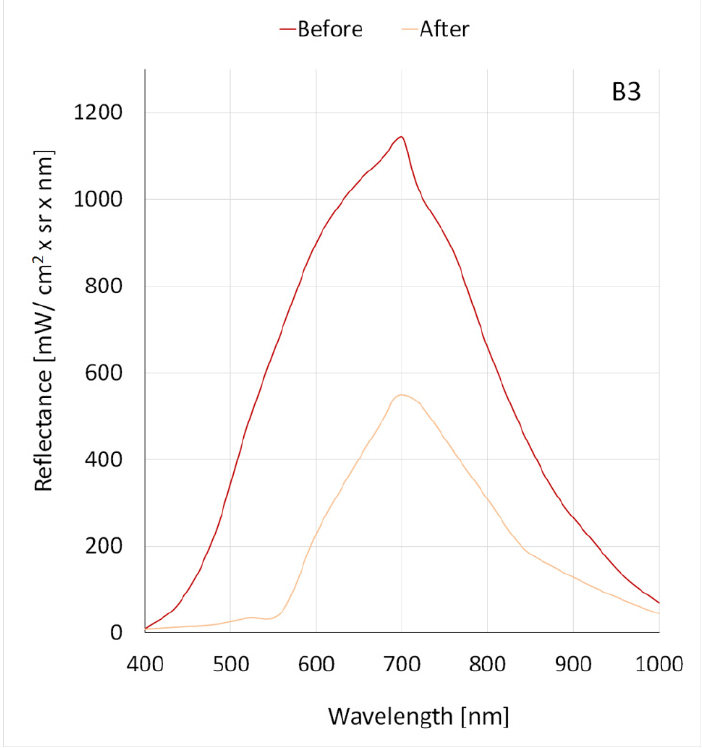
Figure 7. The correlation between the reflectance and the wavelength for the B2 dye before and after the use of the Q-Switched Nd:YAG laser.